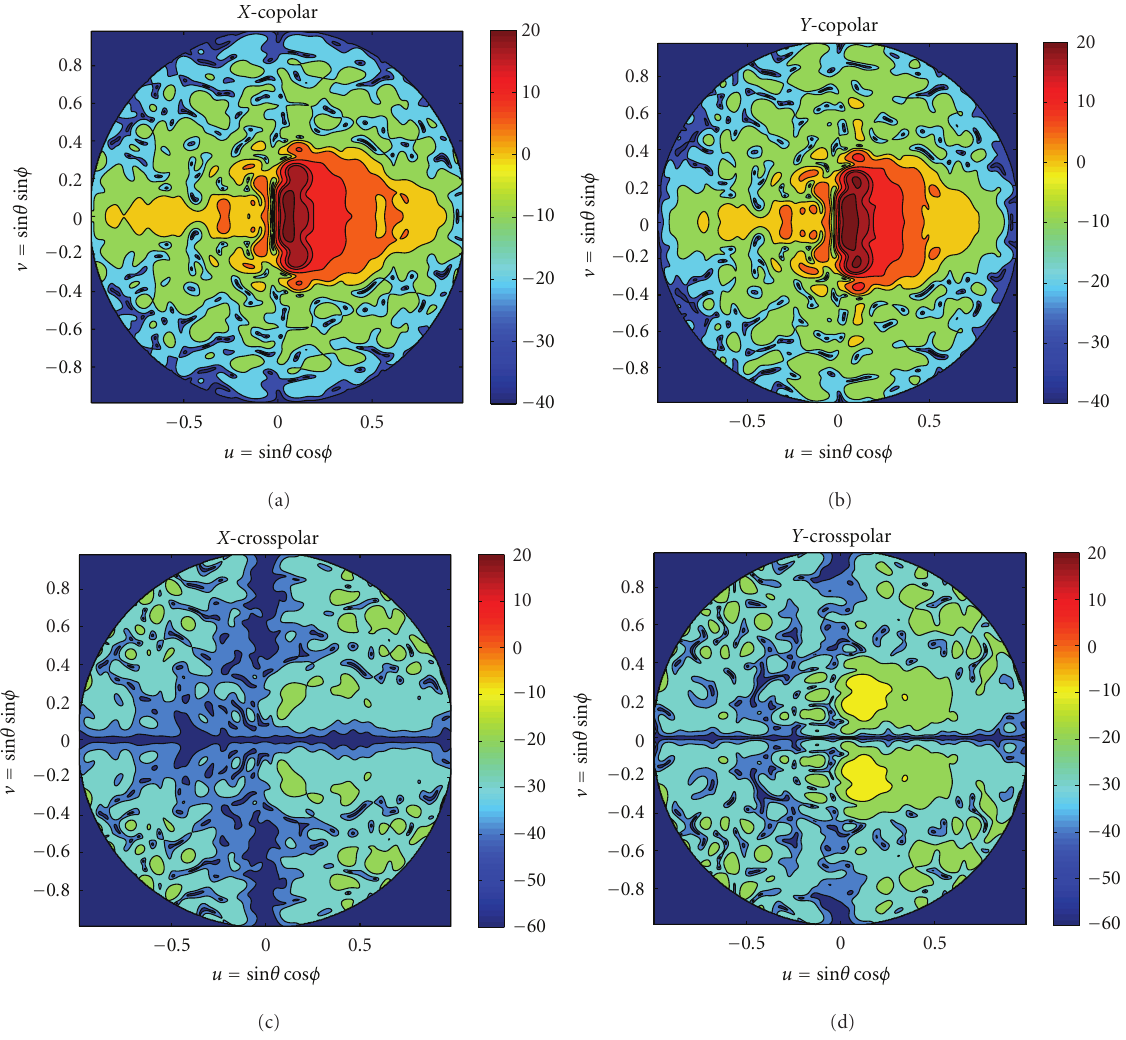
Figure 5: Simulated three-dimensional radiation patterns considering the synthesized phase distribution; vertical (a and c) and horizontal (b and d) polarizations for copular (a and b) and crosspolar (c and d) components. regions. The beam shaping is achieved, and the gain require- ments are fulfilled in a high percentage of the